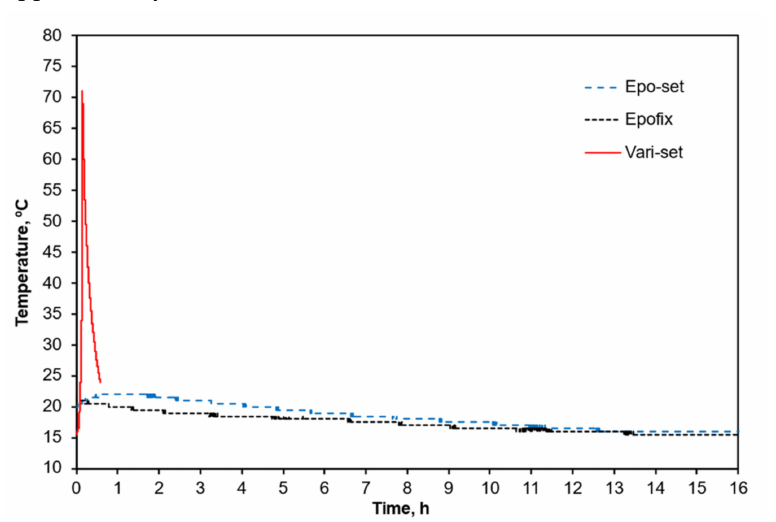
Figure 2. Comparisons of the temperature histories during curing of Epo-set TM , Epofix TM and Vari-set TM mounting